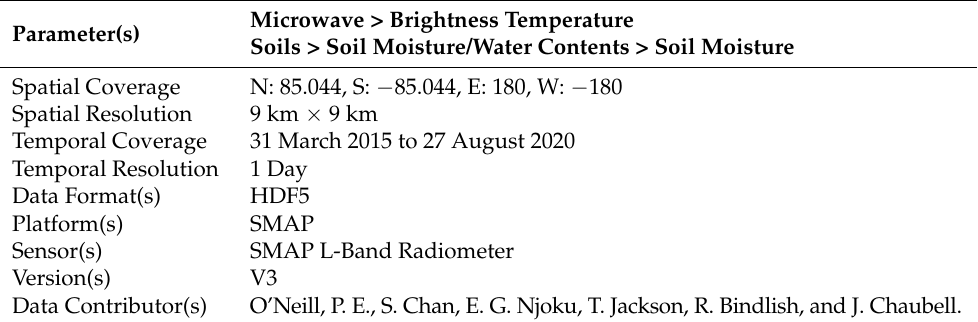
Table 1. Soil Moisture Active Passive (SMAP) system overview (source: O’Neill et al. 2019). Microwave > Brightness Parameter(s)